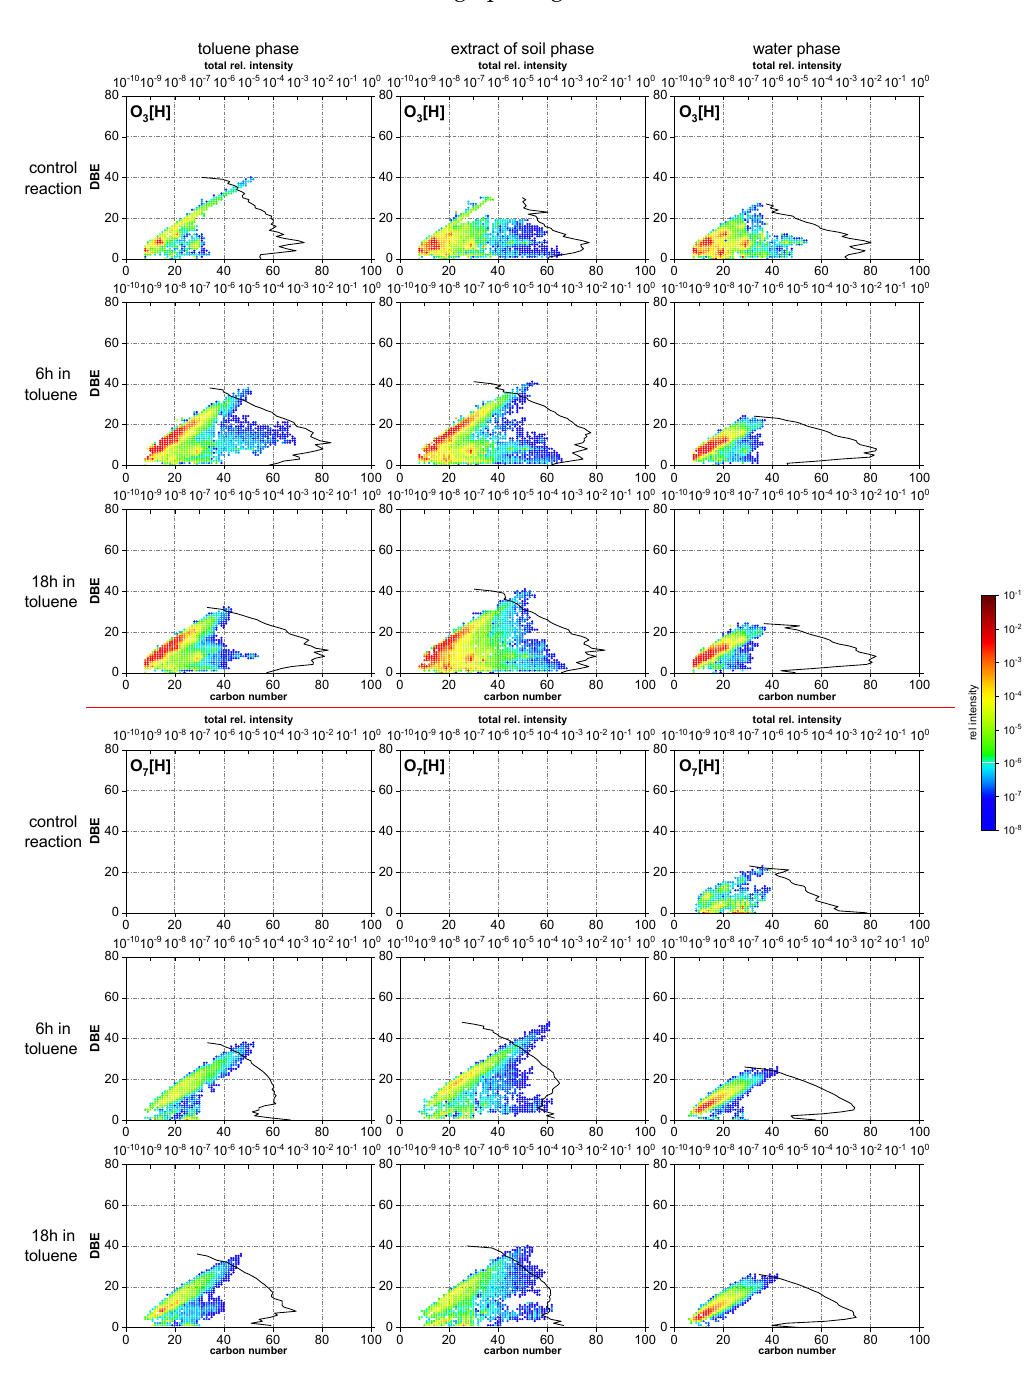
Figure 6. Kendrick plots for O 3 [H] (top graph) and O 7 [H] (bottom graph) classes in the different phases of control reaction, ozonation within 6 h in toluene and ozonation within 18 h in toluene. The total relative intensity for a given DBE is represented on the upper y-axis, while the number of carbon atoms is plotted on lower y-axis.